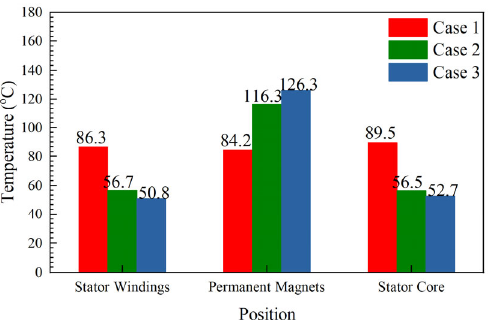
Figure 26. The temperature distribution under the three cases at rated speed: ( a ) Case 1; ( b ) Case 2; ( c ) Case 3.